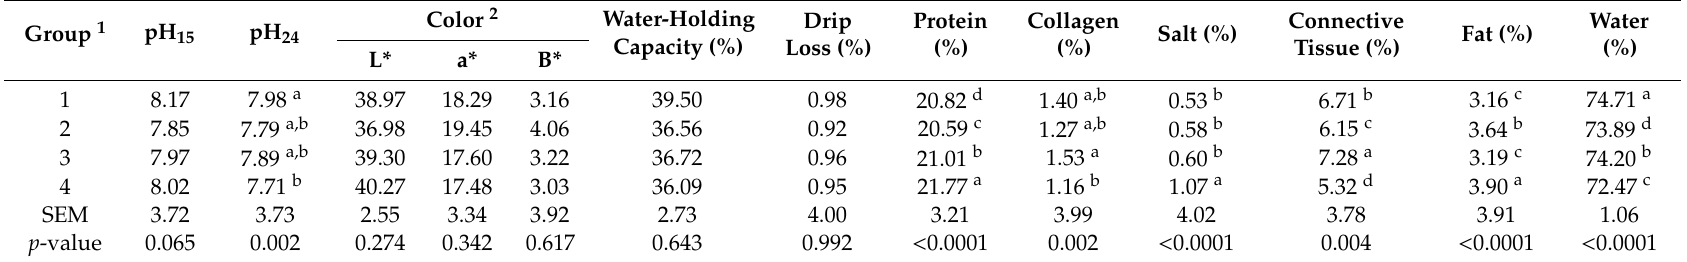
Table 7. Physicochemical parameters of breast muscles from 77-day-old broiler geese.